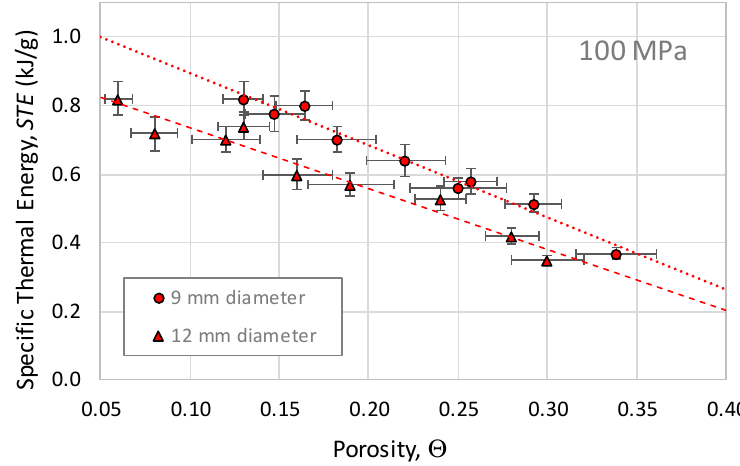
Figure 7. Specific thermal energy versus porosity ( Θ ) in experiments carried out with 100 MPa of applied pressure and the same current densities and powder mass, but different inner diameters of the die (9 and 12 mm). Lines represent the trend of the two sets of points.